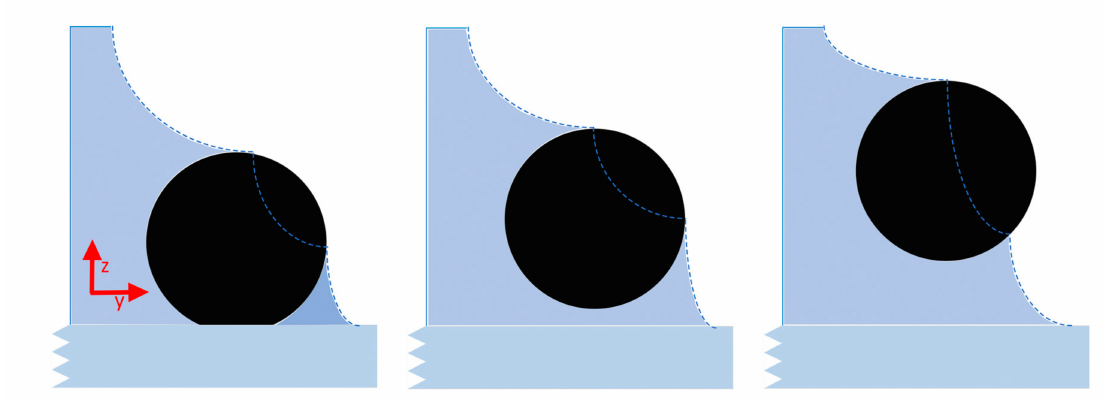
Figure 11. Particles detach from the surface when they meet the front inlet liquid interface, lift up, and move with the